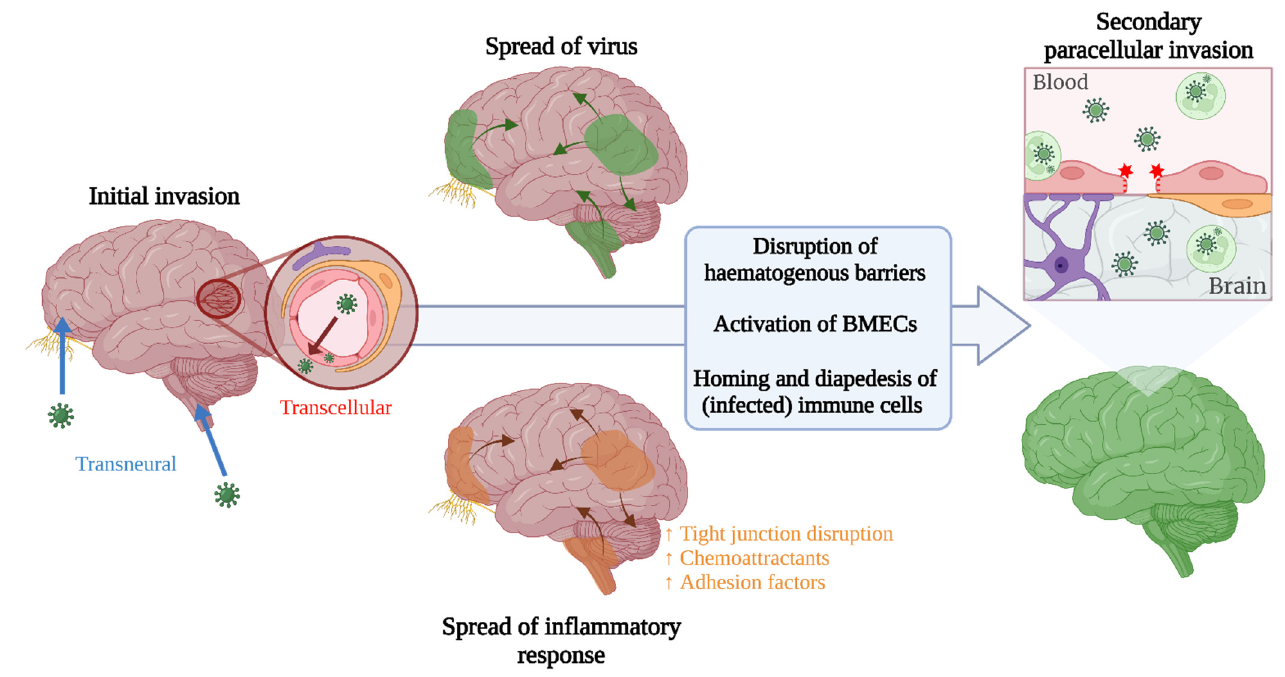
Figure 3. Speculative representation of how neuroinvasive routes could be interlinked across the course of disease, leading to increased viral presence in the brain following an initial invasion via an alternate route. Table 3. Summary table of the potential modes of CNS invasion used by the neurotropic flaviviruses discussed in this review. ✓ = supported by experimental data. X = not supported by experimental data. ? = suggested or yet to be demonstrated. * = also includes differentiated iPSC and CD34+ cord blood-derived BMEC-like in vitro cell models.